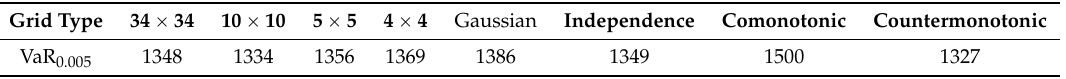
Table 10. Estimated values of VaR 0.005 for different grid types in Example